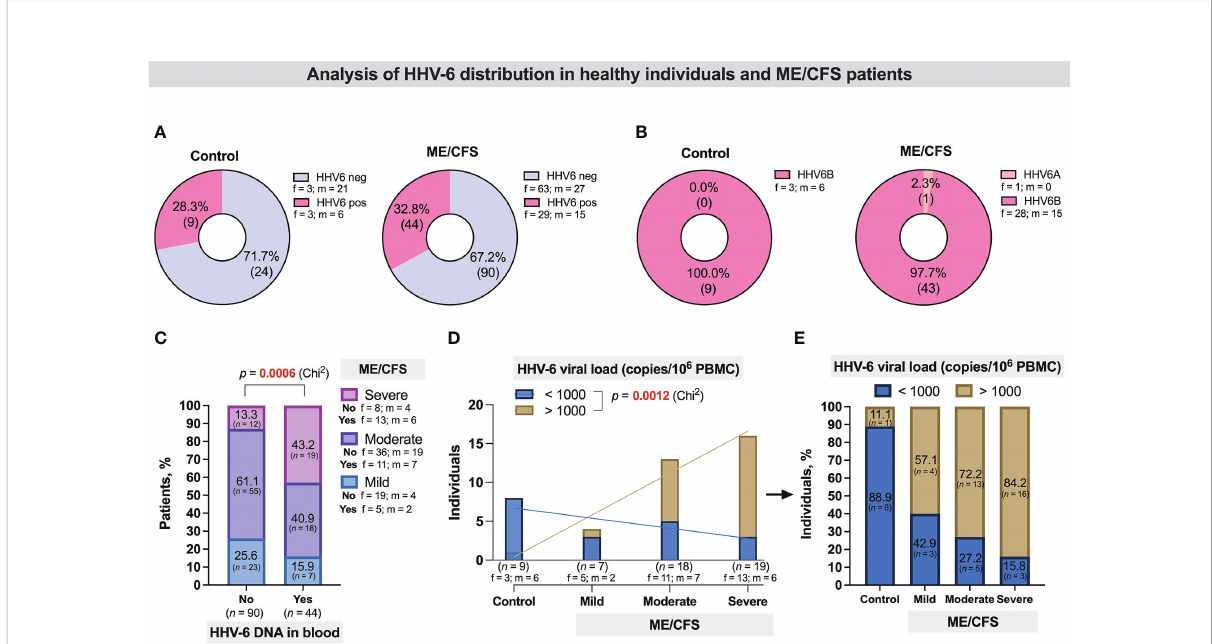
FIGURE 1 (A) Proportion of HHV-6-positive and -negative individuals in the control group and the ME/CFS patient group. (B) Proportion of individuals in the control group and the ME/CFS patient group with detected HHV-6A and HHV-6B. (C) Proportion of HHV-6-positive and -negative patients with different ME/CFS severity; “ no ”— without HHV-6 genomic sequence in blood DNA, “ yes ”— with HHV-6 genomic sequence in blood DNA. (D) Number of control individuals and of mild, moderate, and severe ME/CFS disease course patients with viral load < 1,000 copies/10 6 PBMCs and > 1,000 copies/10 6 PBMCs. (E) Proportion of control individuals and ME/CFS patients with viral load < 1,000 copies/10 6 PBMCs and > 1,000 copies/10 6 PBMCs. f, ,female; m,